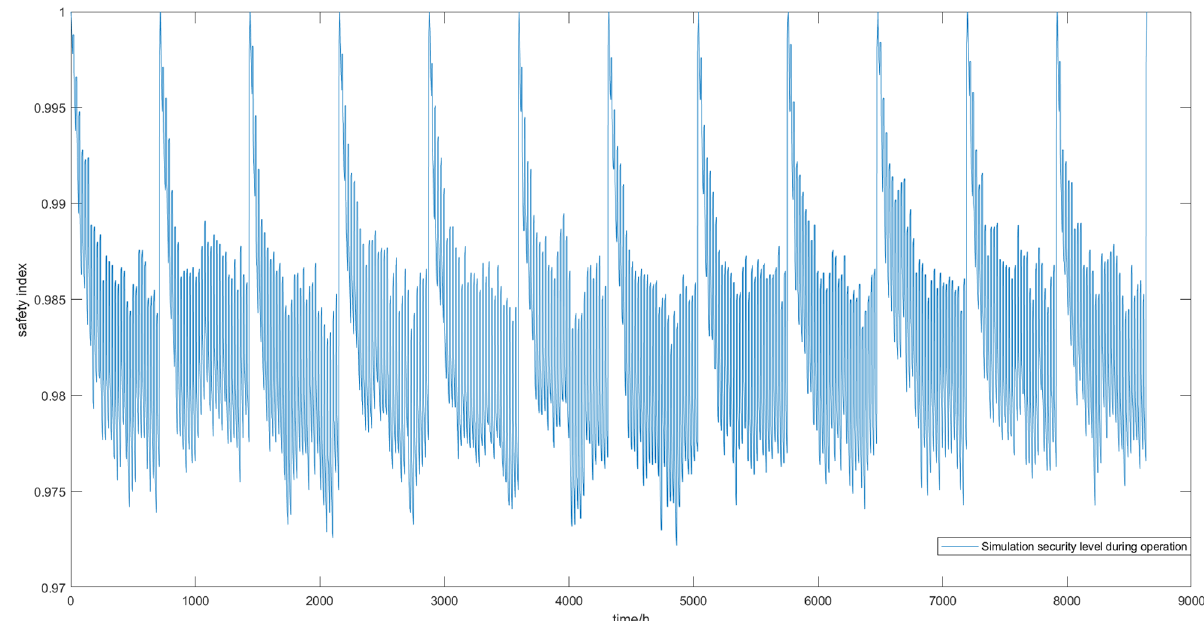
Figure 2. Results obtained from 10,000 simulations.